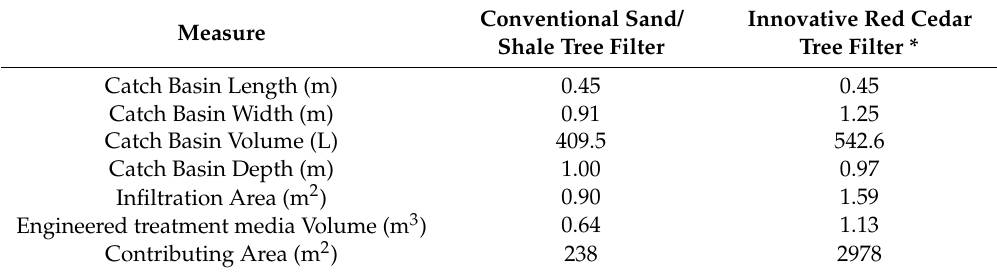
Table 1. Measurements and descriptive information on TF units investigated in this study. Conventional Sand/ Innovative Red Measure Shale Tree Filter